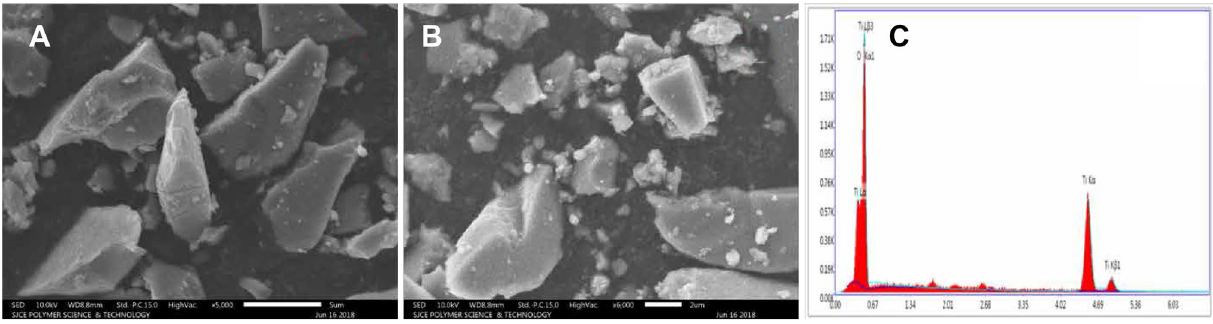
Fig. 4 SEM images ( a , b ) and EDAX ( c ) of the B-TiO